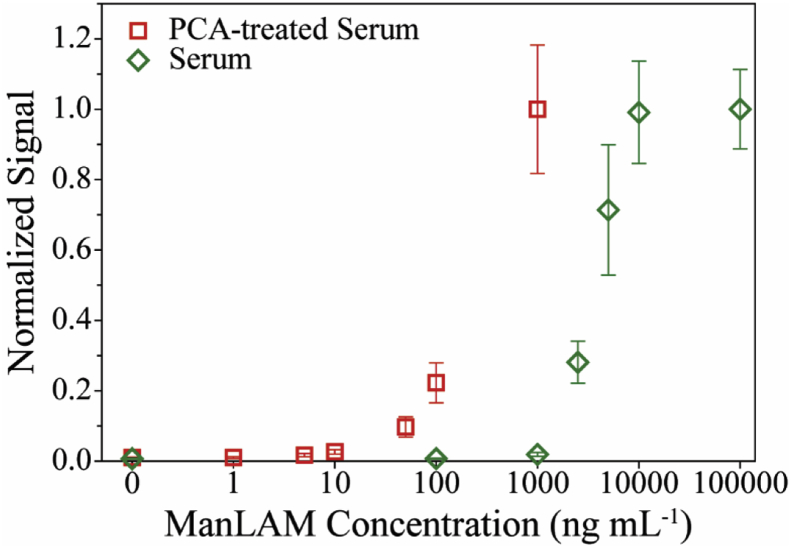
Dose-response plots (response normalized for each data set) for analysis of ManLAM directly from spiked human control serum (green) and for ManLAM spiked into human control serum and then PCA treated (red). These response-normalized plots were adapted using the data in Fig. 3, Fig. 4 in reference 42, which were obtained using a using an immunoassay read out with surface-enhanced Raman scattering (SERS). The LOD for the measurements on spiked serum without PCA treatment and with PCA treatment are 500 and 2 ng mL−1, respectively [42]. The average and standard deviation arise from triplicate assays, with each concentration run in triplicate for each assay. At lower concentrations, the error bars may be smaller than the graphical representation of the data points. (For interpretation of the references to colour in this figure legend, the reader is referred to the Web version of this article.)